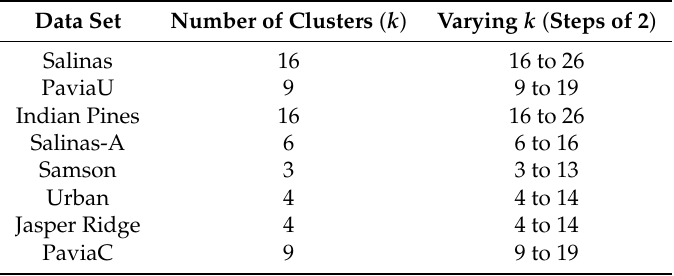
Table 1. Number of clusters for each Hhyperspectral image (HSI) data set and experiment parameter setting. Data